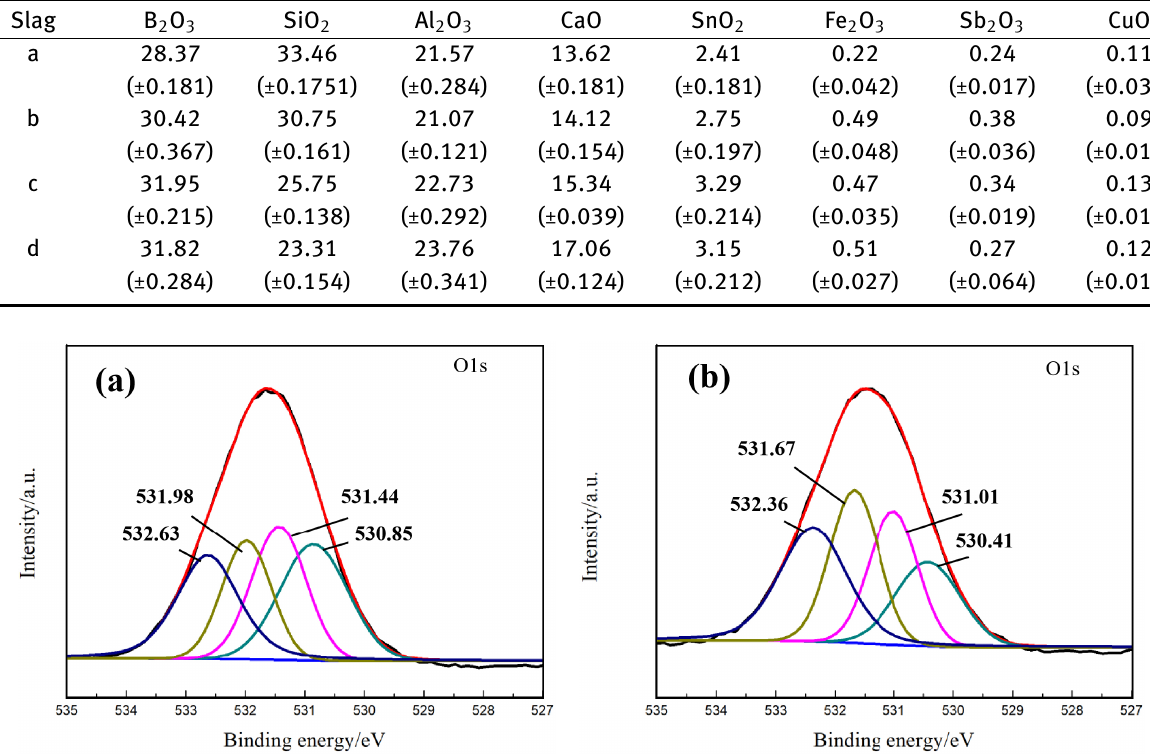
Figure 2: XPS peak differentation imitating analysis of O(1s): a) flux, b)